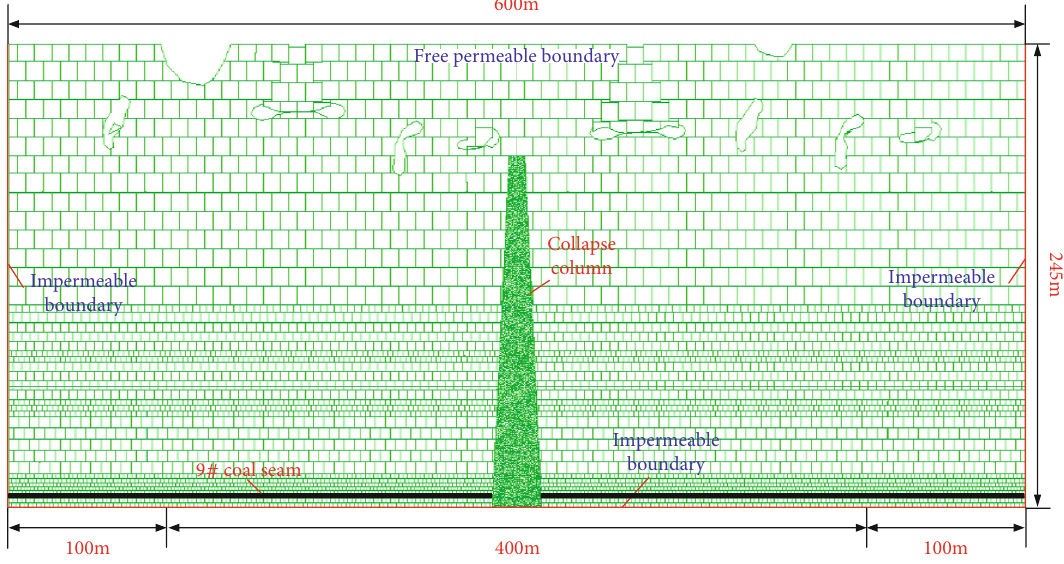
Figure 3: Numerical calculation